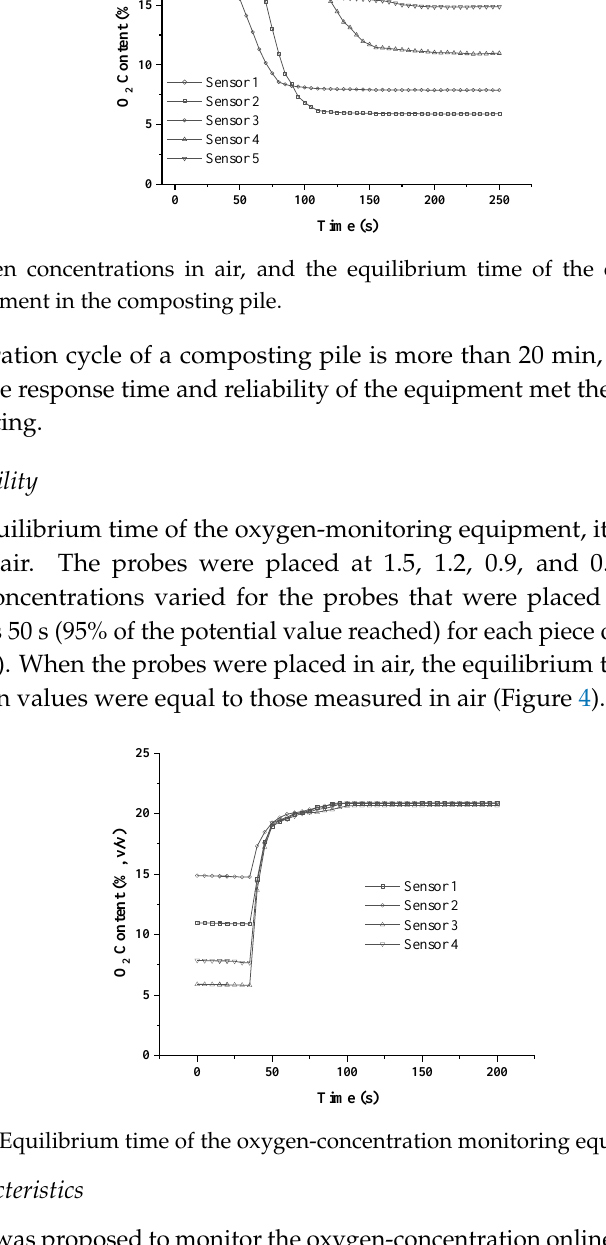
Figure 2. Oxygen concentrations of the mixed gases with high-purity nitrogen and oxygen in different proportions for equipment stability testing.